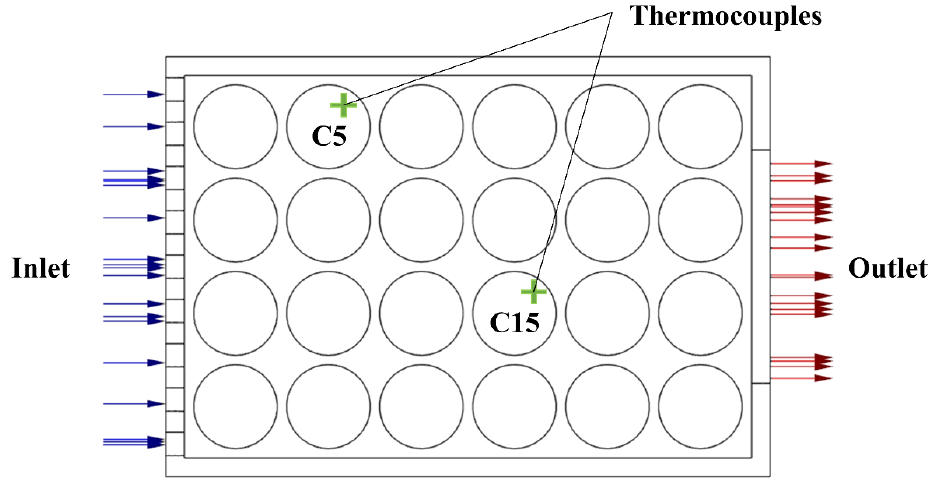
Figure 2. Schematic figure of thermocouple testing